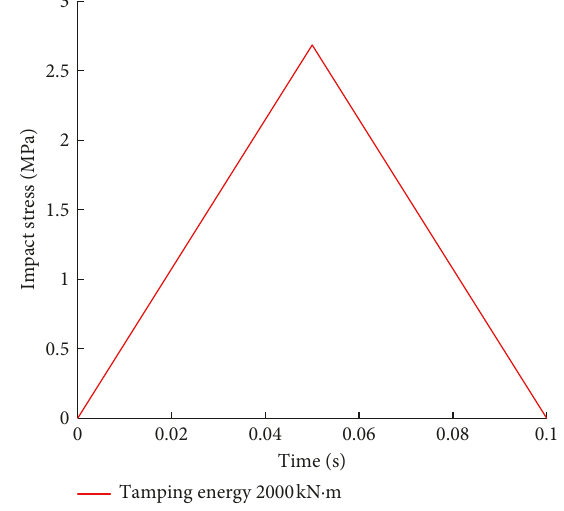
Figure 6: The impact load form.